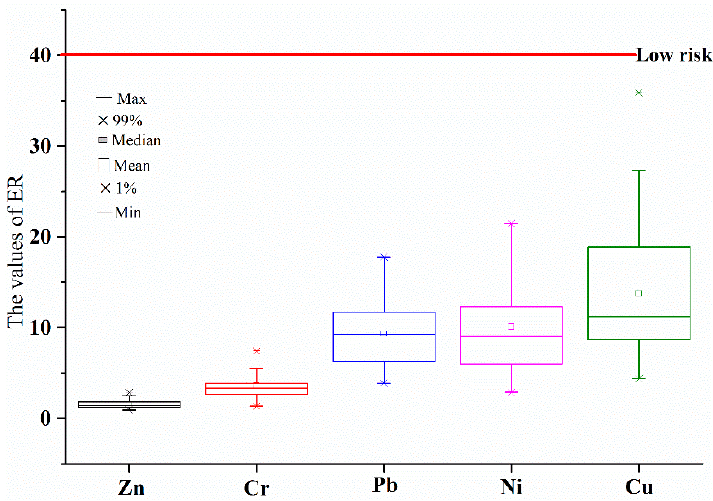
Figure 3. The ecological risks (ER) of single heavy metals in different sampling sites.